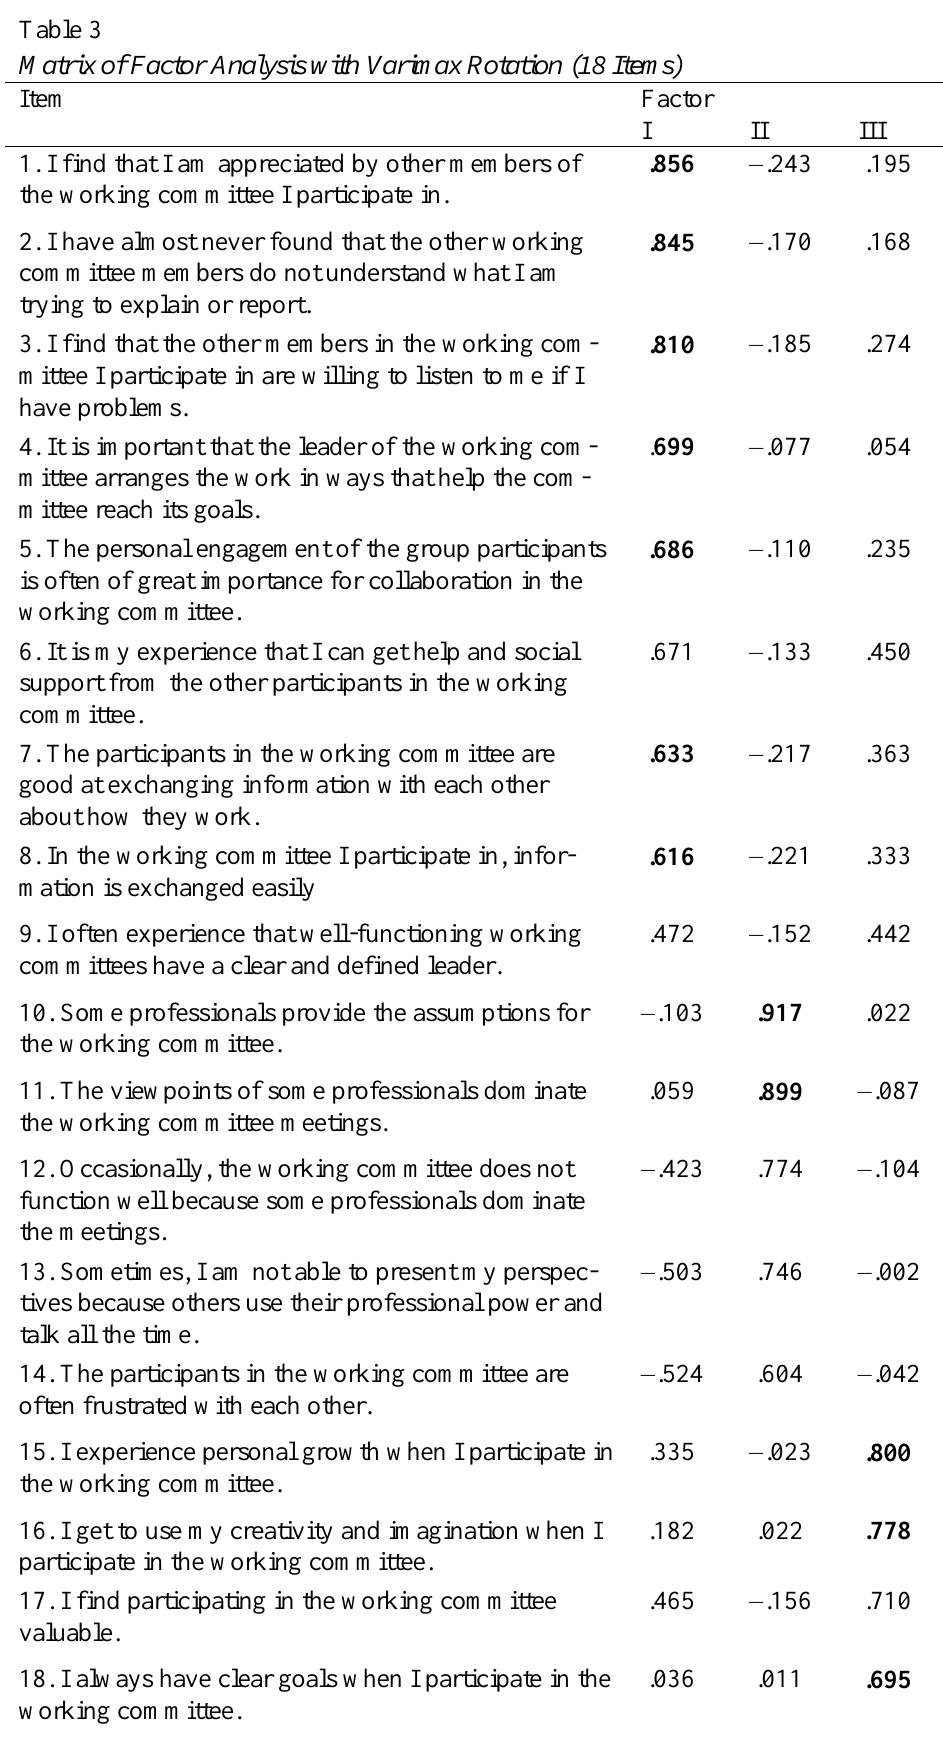
Table 3 Matrix of Factor Analysis with Varimax Rotation (18 Items) Item Factor